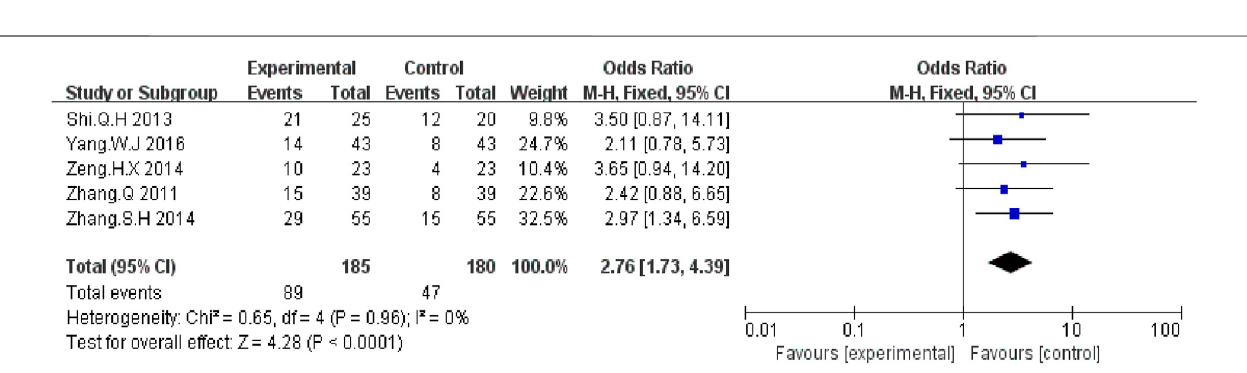
FIGURE 6 | Forest plot of KPS improvement in patients treated with KLT + EGFR-TKI and EGFR-TKI alone.